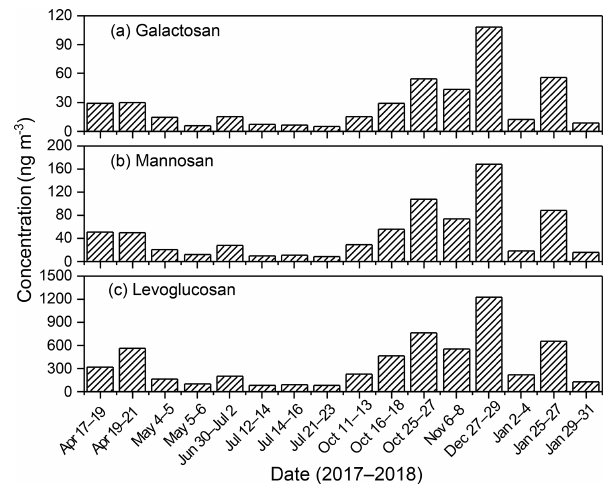
Figure 1. Seasonal trends (a, b, c) of anhydrosugars in urban Bei- jing aerosols from April 2017 to January 2018.